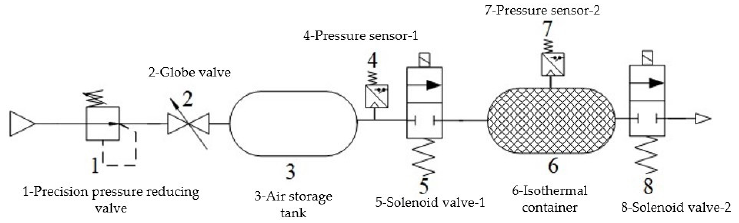
Figure 11. Schematic diagram of measuring sonic conductance of the solenoid valve by isothermal container venting method.